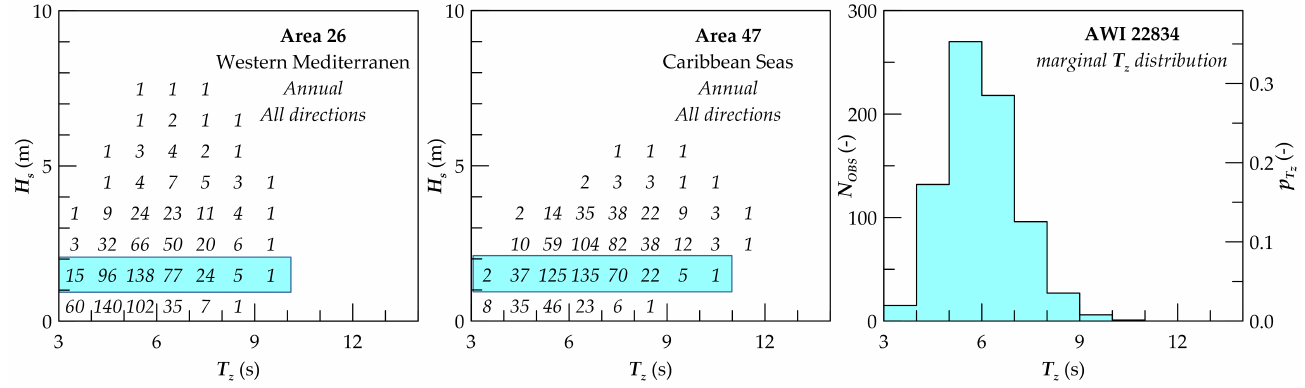
Figure 1. Environmental conditions considered by AWI 22834